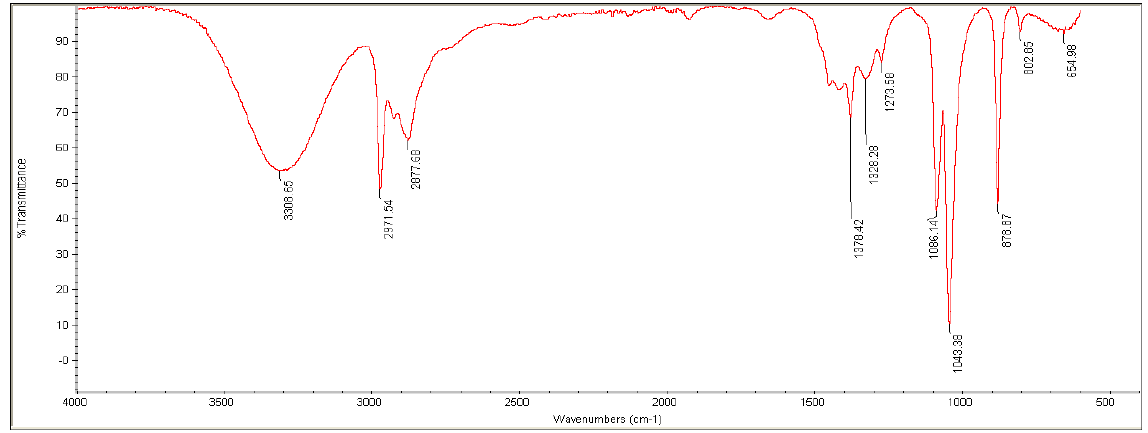
spectrum for dihydrocodeine alkaloid 211 nm (13) .